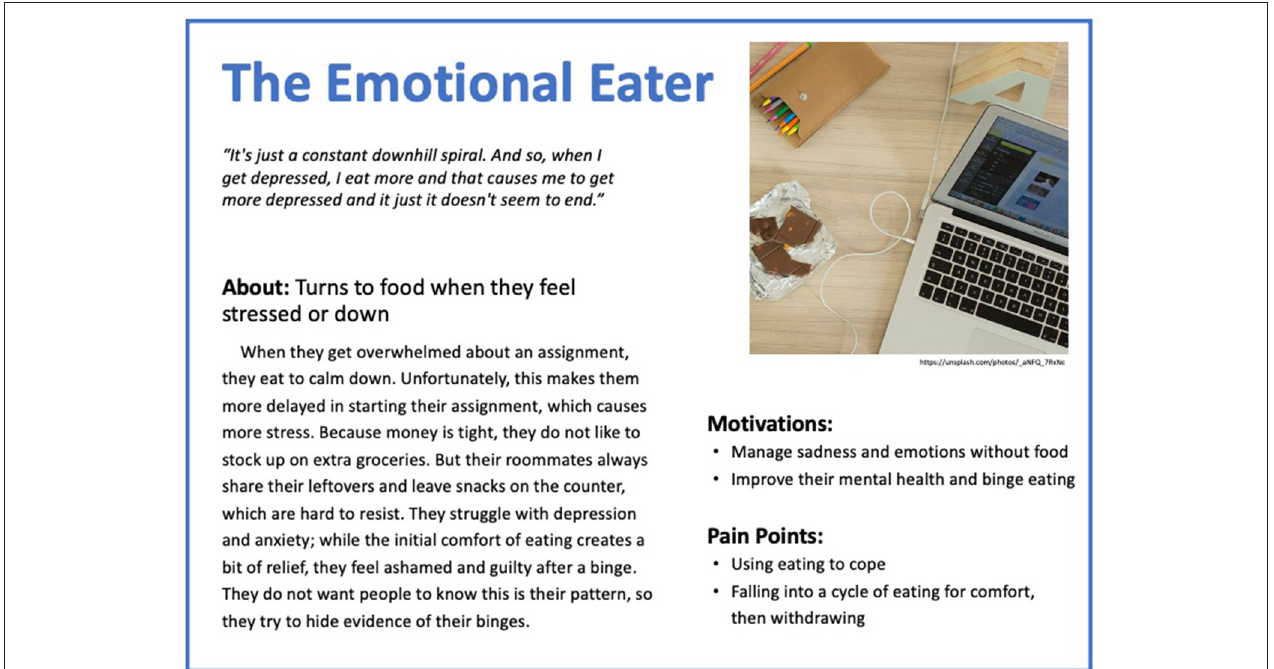
FIGURE 3 | Persona 3: The Emotional Eater.